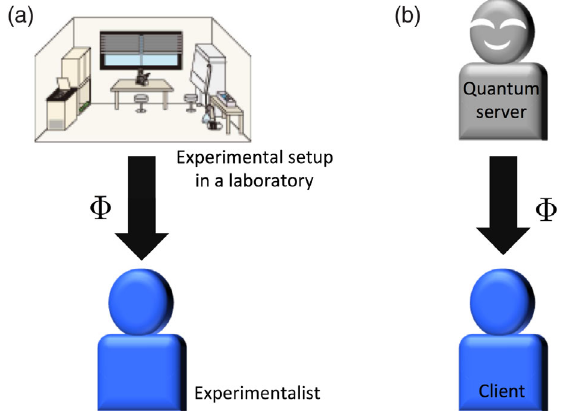
FIG. 1. The prover-verifier game considered in this paper. (a) An experimentalist (verifier) wants to verify the correctness of a state Φ from the experimental setup (prover). (b) In cloud quantum computing of the type of Ref. [45], a client (verifier) asks a remote server (prover) to generate and send a certain quantum many-qubit state Φ . The client wants to verify the correctness of the state sent from the